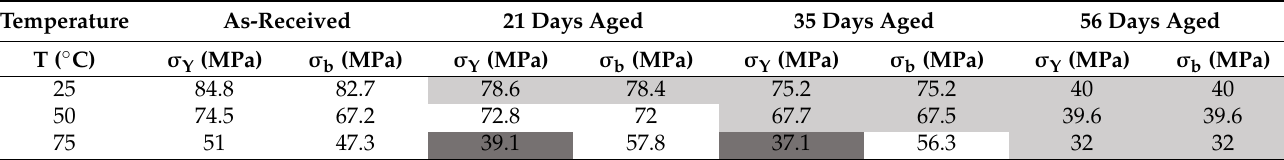
Figure 5. ( a ) Stress-strain curves for different temperatures of as-received PET; ( b ) stress-strain curves for different temperatures of 21 days aged PET; ( c ) stress-strain curves for different temperatures of 35 days aged PET; ( d ) stress-strain curves for different temperatures of 56 days aged PET. Table 5. Yield stress ( σ Y ) and tensile stress at break ( σ b ); dark grey background colour—yield stress values determined as for metals; light grey background colour—similar or the same yield and tensile stress values resulting from the change of material properties and its brittle